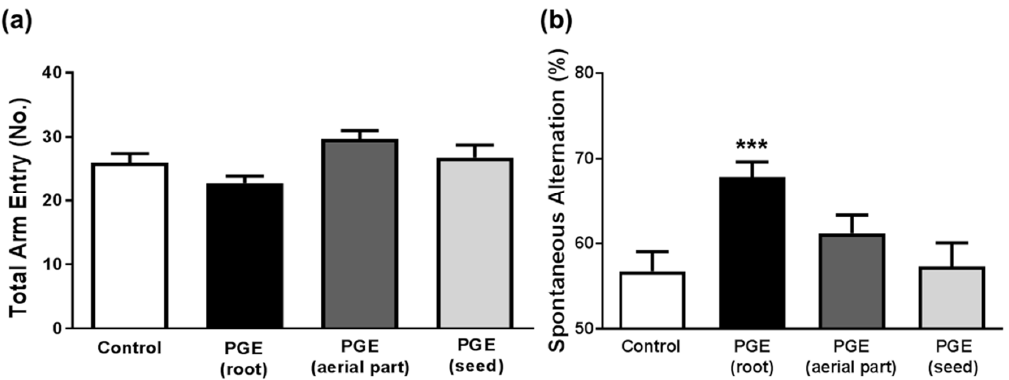
Figure 2. Behavioral test to determine the enhancing effect of PGE on cognition. The Y-maze test